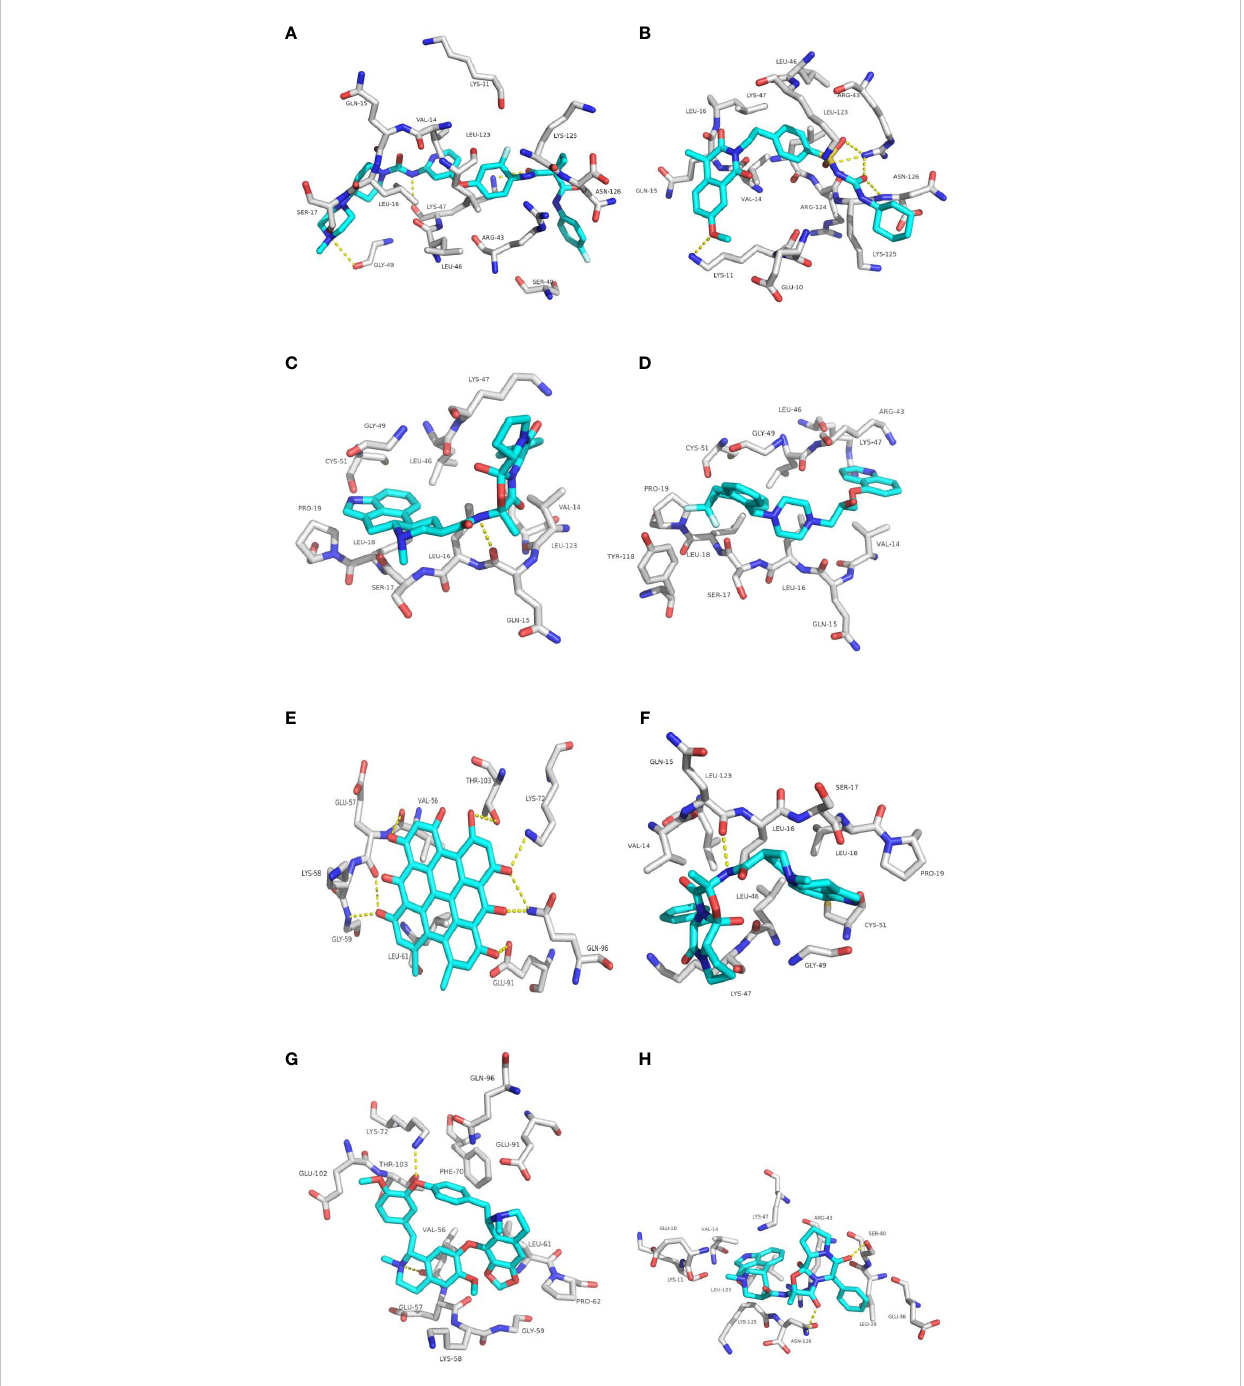
FIGURE 3 Binding model of Small molecule ligand with 40S-SARS-CoV-2-Nsp1 (BQ.1) complex interface. The yellow dotted line indicates the interaction distance (Å). (A – H) are Golvatinib, Gliquidone, Dihydroergotamine, Zosuquidar, Hypericin, Ergotamine, Cepharanthine,